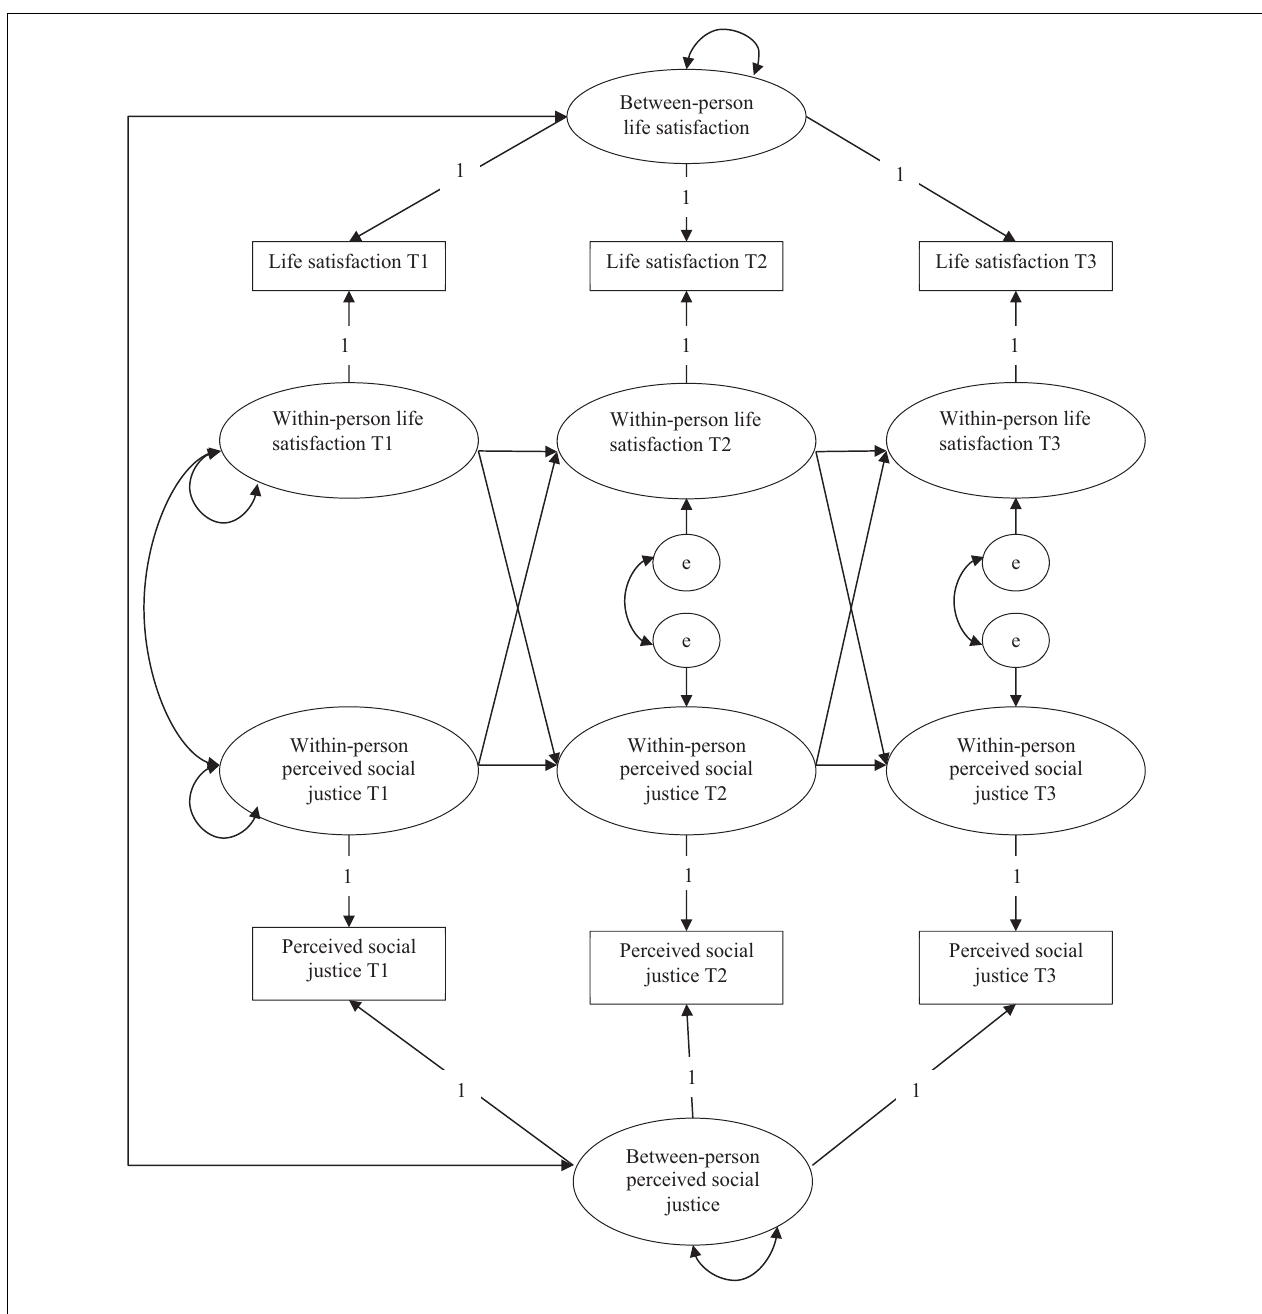
FIGURE 1 | The random intercept cross-lagged panel model